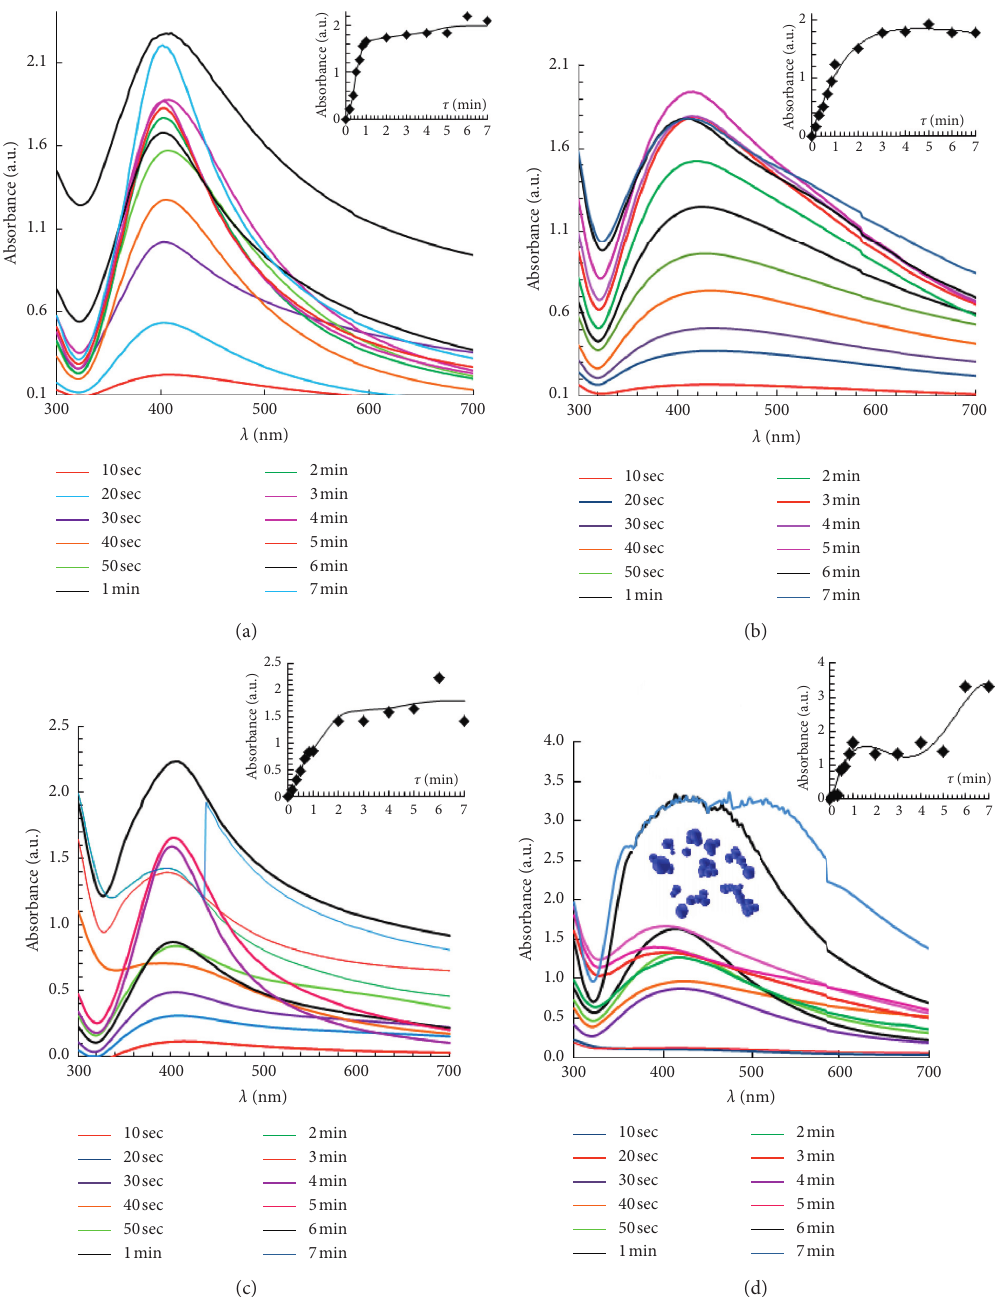
Figure 1: Absorption spectrums of silver nanodispersions with the addition of stabilizer ,PVA, at different concentrations of Ag + : 0.3mmol/ l (molar ratio [Ag + ]:[PV A ] � (1):( ∼ 0.0055) (a), 0.5mmol/l [Ag + ]:[PV A ] � (1):( ∼ 0.0055) (b), 1.0mmol/l ([Ag + ]:[PV A ] � (1):( ∼ 0.003) ( s ), and 3.0mmol/l [Ag + ]:[PV A ] � (1):( ∼ 0.002)